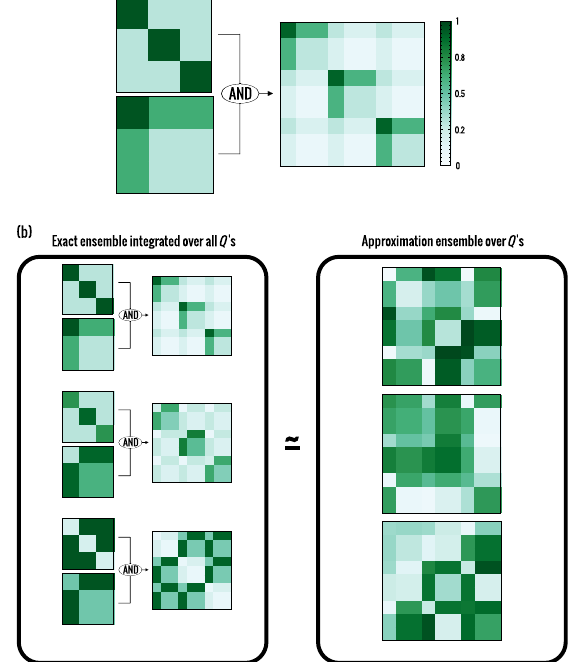
FIG. 2. Exact and approximate multilayer SBM ensembles. (a) Two independent single-layer SBMs aggregated using the AND mechanism. We represent each single-layer SBM by its node-to-node connection probability matrix (indicated in the shades of green shown in the color bar; note that node ordering is different in each SBM). The aggregation of the two layers can also be represented as a single-layer SBM, in which each group comprises the nodes that belong to the same pair of groups α in layer 1 and γ in layer 2; this is the intersection partition P I . Moreover, if group r in P I corresponds to groups α in P 1 and γ in P s in P β in P δ in P 2 , and group I corresponds to groups 1 and 2 , then the probability of connection in the single-layer SBM is q 1 q 2 P P q AND 1 and 2 , we rs ¼ γδ . (b) For a fixed pair of partitions αβ integrate over the ensemble of all possible probability matrices Q Q ; Q q AND Q 1 and 2 [Eq. (3)]. For each pair ð 1 2 Þ , the resulting rs are therefore correlated. In our approximation, we assume that the elements of the intersection q AND rs are randomly drawn and independent of each